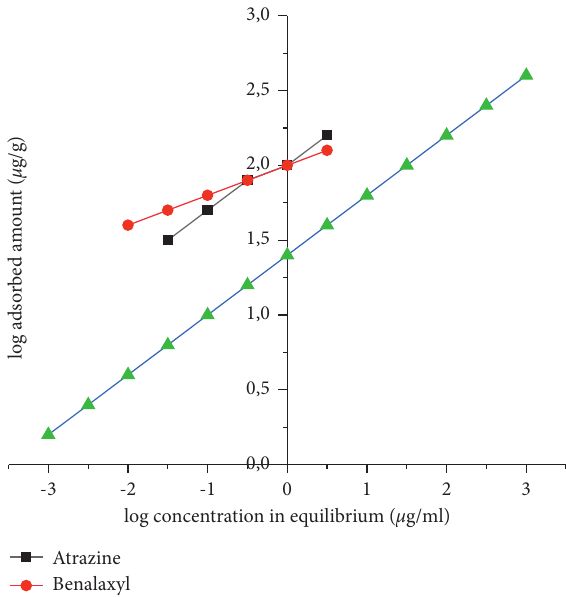
Figure 7: Freundlich adsorption isotherm for benalaxyl and atrazine in coal FAPP (Kosovo